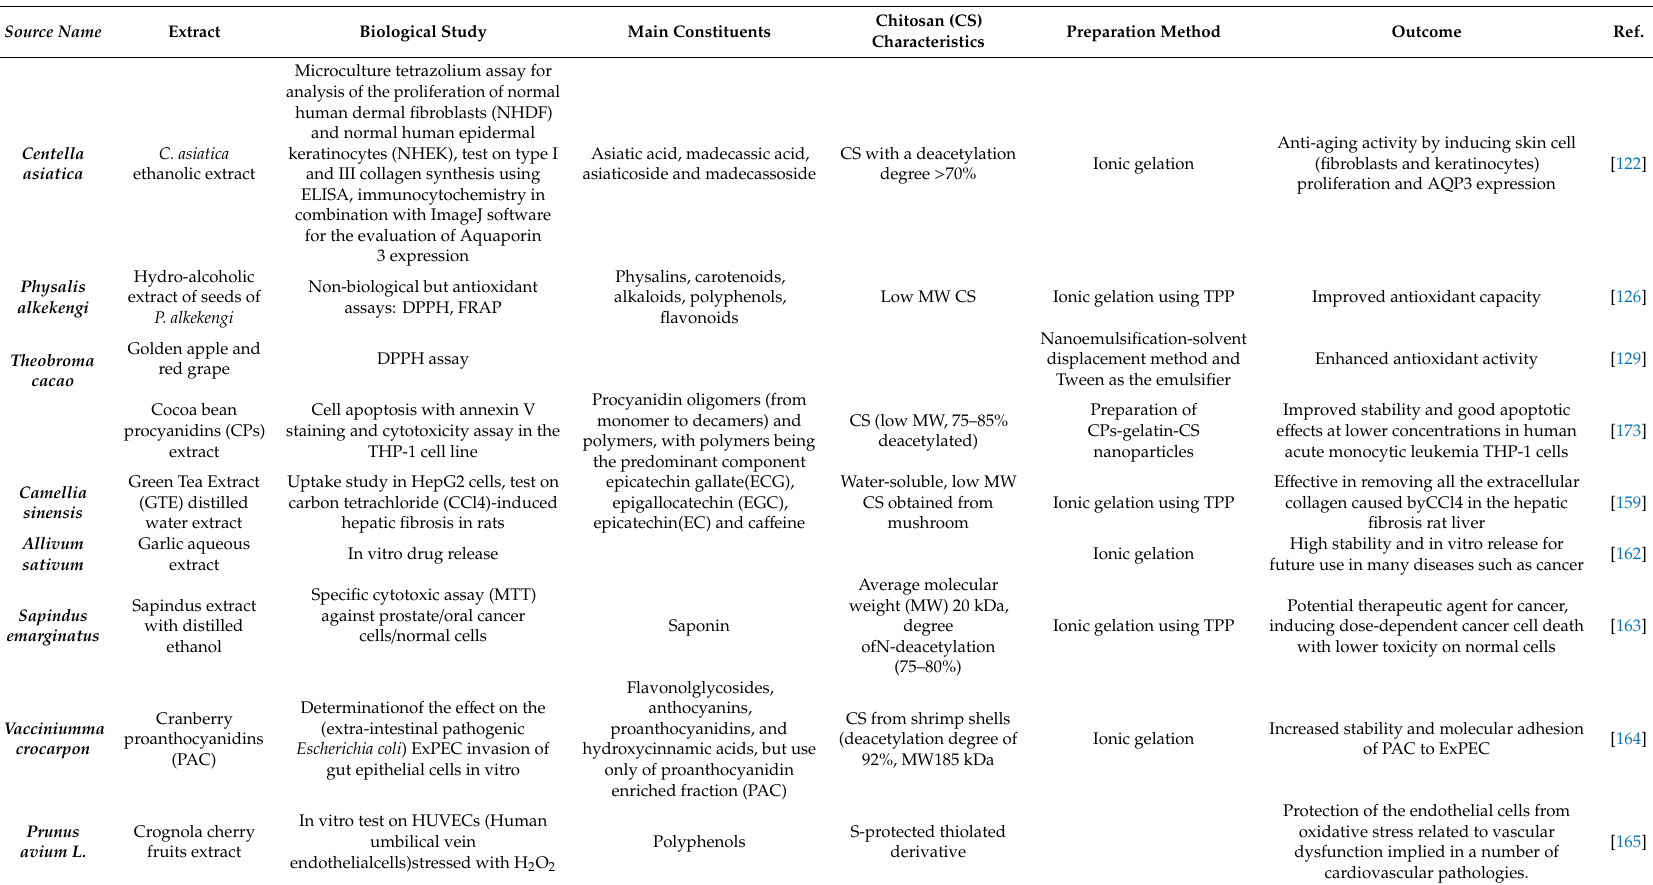
Table 1. Chitosan as a matrix for the encapsulation of natural